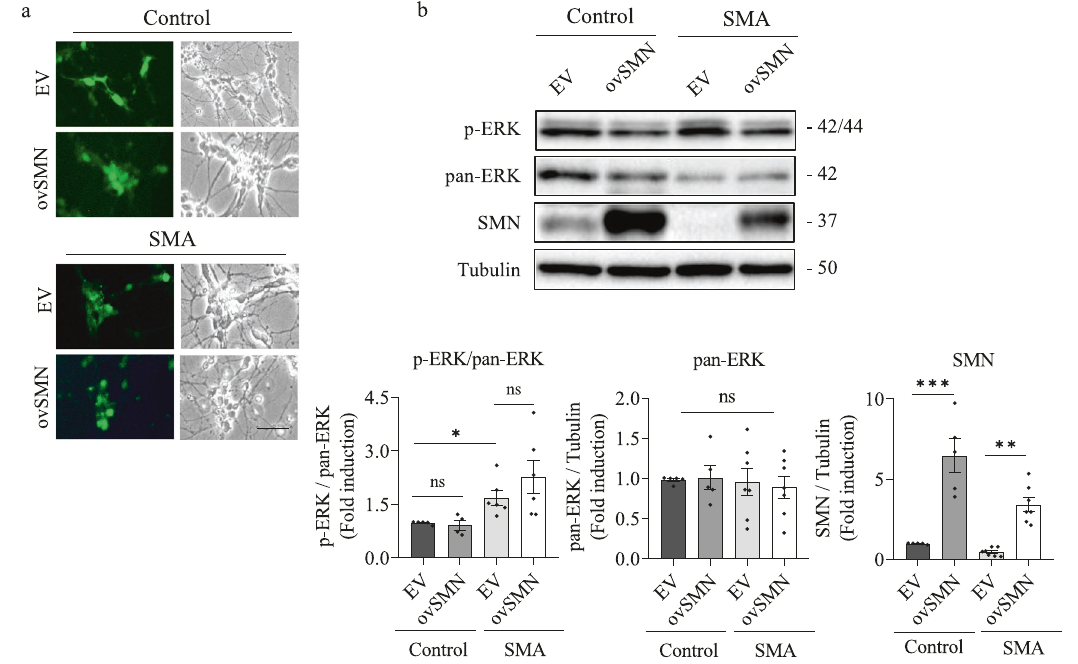
Fig. 5 SMN overexpression does not prevent ERK hyperphosphorylation in SMA MNs. Control and SMA human MNs were plated and transduced with lentivirus containing the empty vector (EV) or the ovSMN construct and cultured for 7 days. a Representative microscopy images of 7-day transduced cultures. GFP positivity (left panel) indicates lentivirus transduced cells in the culture dish. Scale bar, 60 μ m. b Protein extracts of transduced MN cultures were submitted to western blot analysis and probed with anti-p-ERK or anti-SMN antibodies. Membranes were stripped and reprobed with anti-pan-ERK antibody or with anti- α -tubulin antibody. Graphs represent the expression of p-ERK vs pan-ERK, pan-ERK vs α -tubulin, and SMN vs α -tubulin, and correspond to the quanti fi cation of 4 independent iPSCs differentiation cycles ± SEM. Asterisks indicate signi fi cant differences using Student t test (* p < 0.05) or one-way ANOVA with Tukey ’ s multiple comparisons test (** p < 0.005; **** p < 0.0001; ns no signi fi cant differences p >